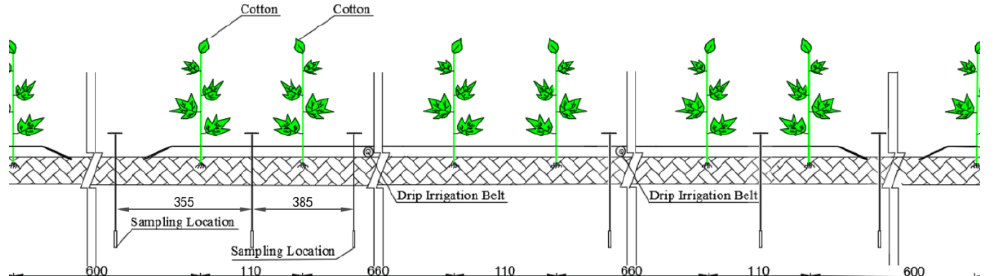
Figure 2. The planting pattern of “one mulching film, two drip irrigation belts and six rows of cotton” has been adopted in the study area; the spacing of narrow rows of cotton is 110 mm, the wide rows is 660 mm. Sampling locations were located under drip irrigation tapes, in the middle of narrow rows of cotton and in the middle of two mulching films .